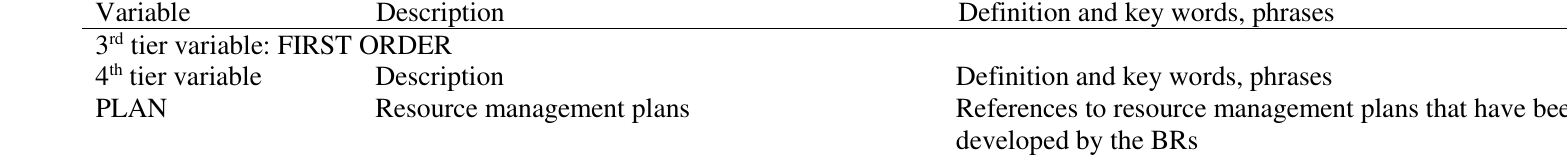
Table A5.3 Adapted from Plummer and Armitage (2007)